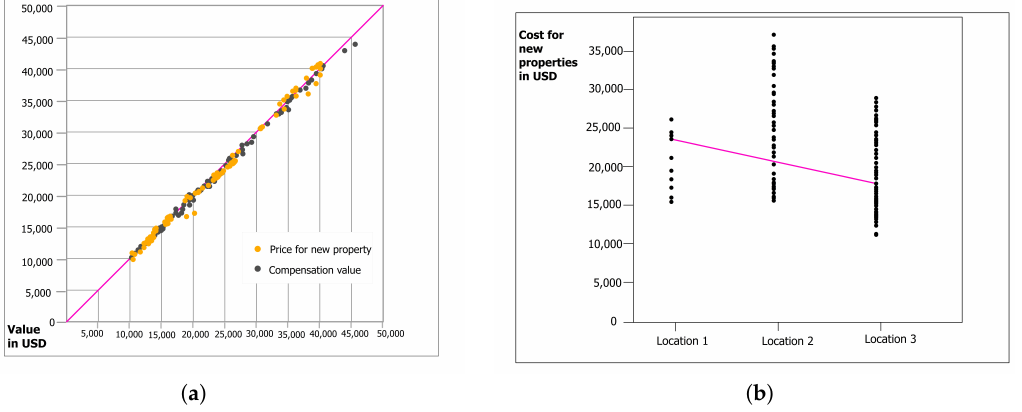
Figure 5. Figure6.This is a figure, Schemes follow the same formatting. If there are multiple panels, Figure 6. ( a ) Trends in cost of new buildings, compared to compensation value; ( b ) Trends in prices Table 5. Cost of new properties, compared to the they should be listed as: ( a ) Description of what is contained in the first panel. ( b ) Description of what of new buildings, according to the location of resettlement for the expropriated people. Data sources: is contained in the second panel. Figures should be placed in the main text near to the first time they Households survey and field observations. are cited. A caption on a single line should be centered Table 5. Cost of new properties, compared to the compensation.